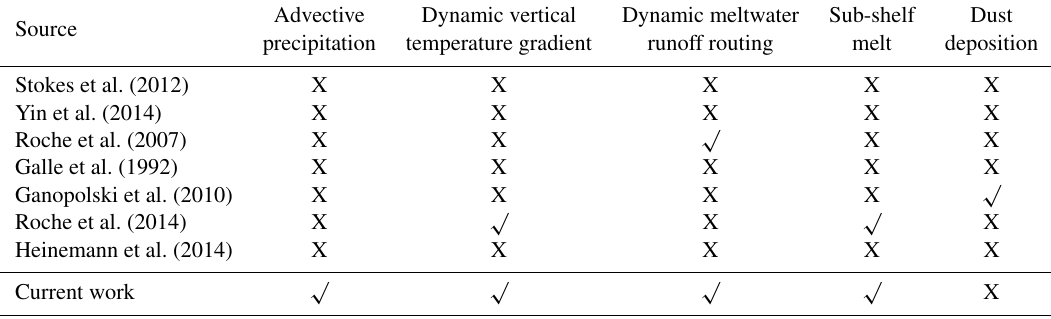
Table 1. Feedbacks/interactions sporadically included in previous studies between the ice sheet model and the rest of the climate system, compared to the current study. None of these feedbacks/interactions include changes to land mask and bathymetry except for parameterized Bering Strait throughflow. Tick indicates included and cross indicates not